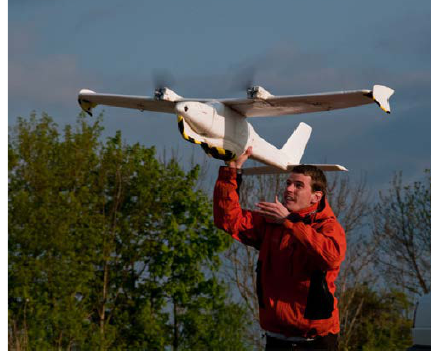
Figure 1. MAVinci Sirius I being launched by